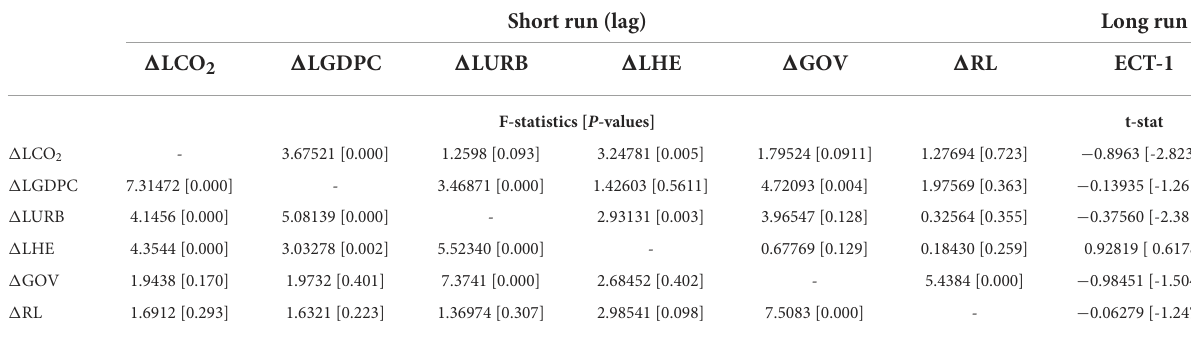
TABLE 9 Granger causality